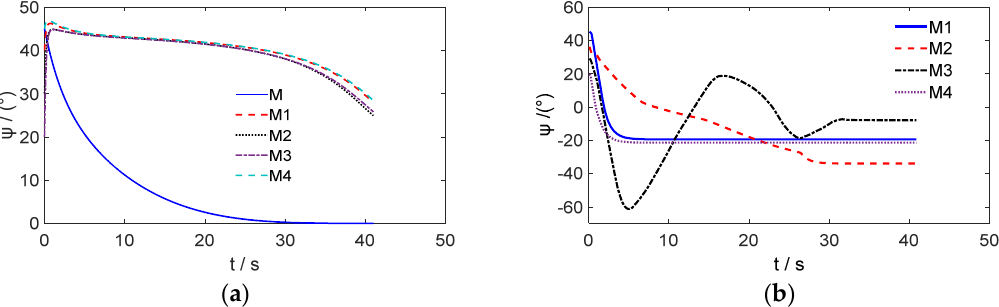
Figure 18. Comparison of the trajectory deflection curves of each follower missile between the proposed guidance scheme and the time cooperative guidance scheme: ( a ) Time cooperative guidance law; ( b ) MPC-based cooperative guidance law.